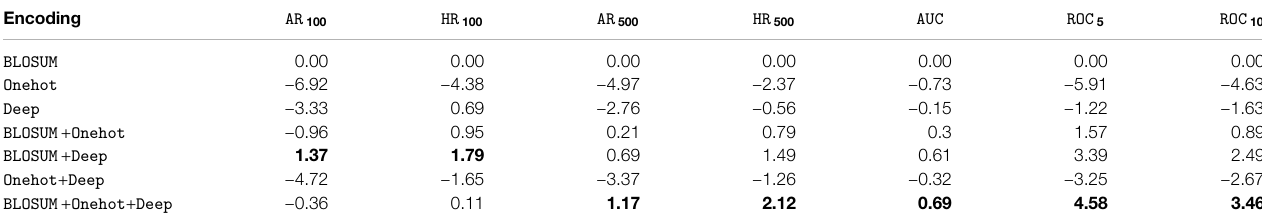
TABLE 6 | Encoding performance comparison on SpConvM with H v using BLOSUM ( H ). Encoding AR 100